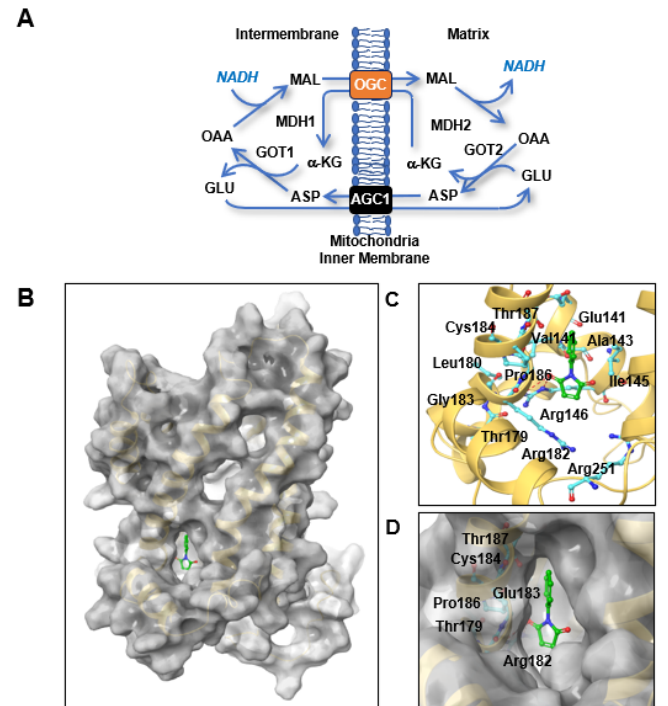
Figure 1. Important binding interactions for the docked conformations of NPM using the OGC homology model. ( A ) The MAS for NADH transport into the mitochondrial matrix. NPM, N -phenylmaleimide; OGC, oxoglutarate carrier; AGC1, aspartate-glutamate carrier isoform 1; OAA, oxaloacetate; α -KG, α -ketoglutarate. ( B ) The binding site in the OGC model is shown as a light orange ribbon; NPM is shown in green in a stick-ball structure. ( C ) Detailed interactions between NPM and OGC are shown with a stick model, and residues involved in the interaction with NPM are presented in the stick-ball style colored by atom type (C, cyan; N, blue; O, red). H-bonds are indicated by red dashed lines. ( D ) Close-up left-hand view of the predicted binding of NPM to OGC. The ligand is depicted in the stick-ball style. Figures were drawn in Maestro (Schrödinger, LLC, New York, NY, USA, 2020).